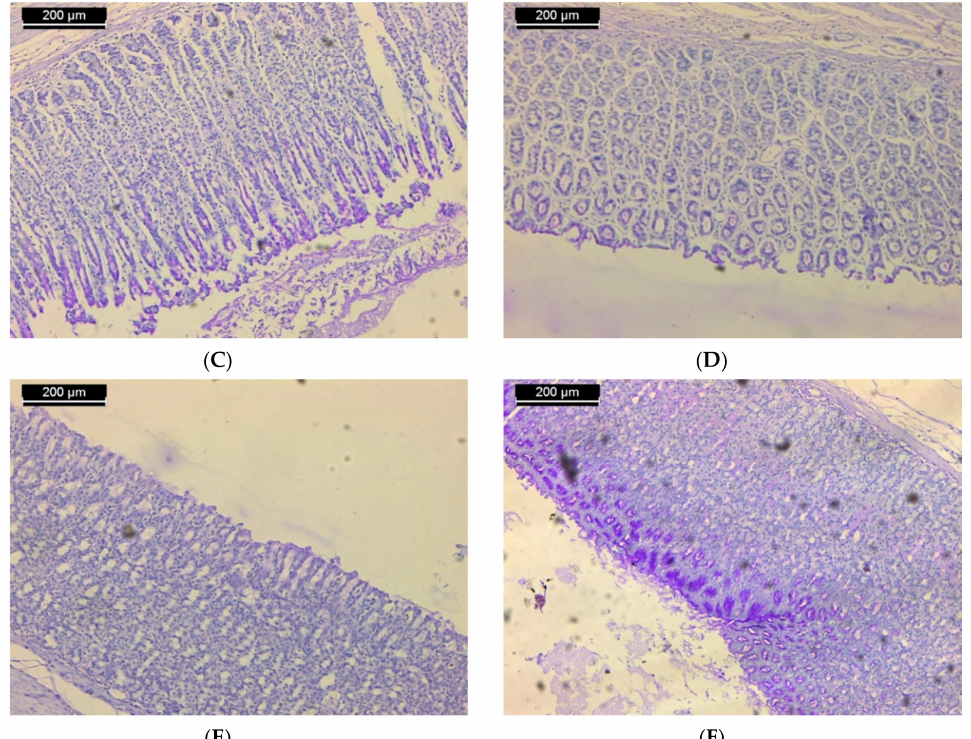
Figure 3. Sections of the stomachs of rats from: ( A ) the normal control group showed the polysac- charide material in the gastric mucosa. These materials are localized in the mucosa epithelium; ( B ) the ulcerated group showed a lack of stainable material; ( C ) the group treated with 50 mg/kg of ST-1 showed dense staining as compared with the group which received ethanol only; ( D ) the group treated with 50 mg/kg of ST-1 exhibit weak stainable material; ( E ) the group treated with 100 mg/kg of ST-1 showed heterogeneous staining, such that the degenerated surface epithelial cells and mucous neck cells were almost devoid of stainable material, while the outer half of the fundic mucosa was densely stained; ( F ) the group treated with ranitidine showed that the polysaccharide contents of the mucosal epithelium were almost similar to that of the control rats (PAS stain; scale bar, 200 µ